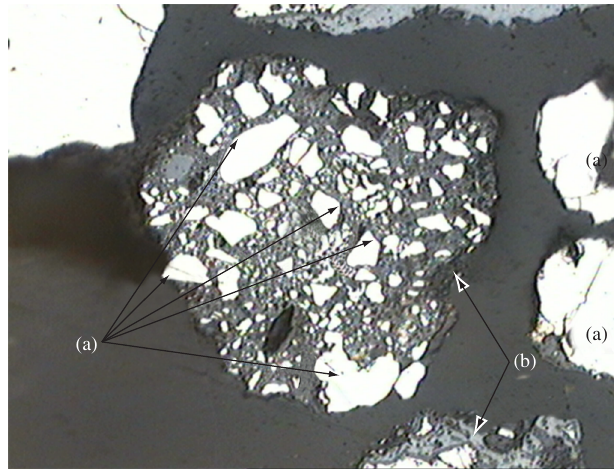
Figure 3. Optical Micrograph of FeSiMn alloy particles aggregated to slag. 220 x. a) alloy, and b) slag.